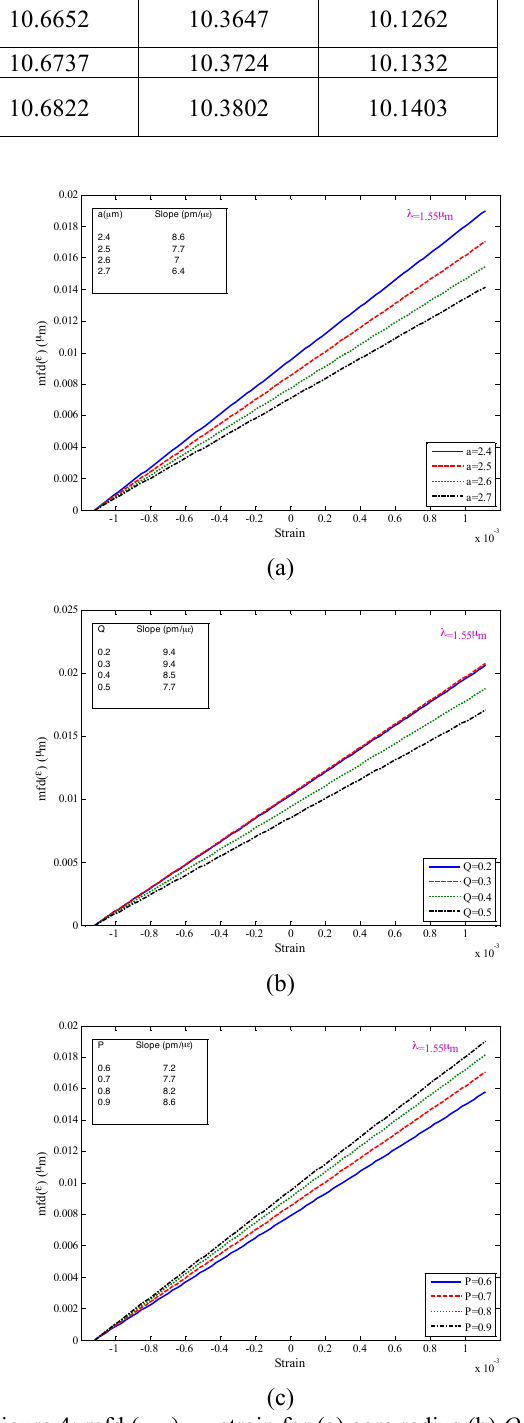
Figure 4: mfd ( µ m ) vs. strain for (a) core radius (b) Q (c) P ,as